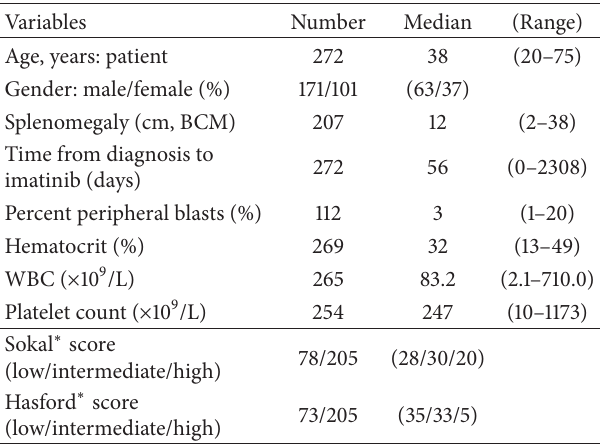
Table 1: Summary of clinical parameters of all 272 patients at